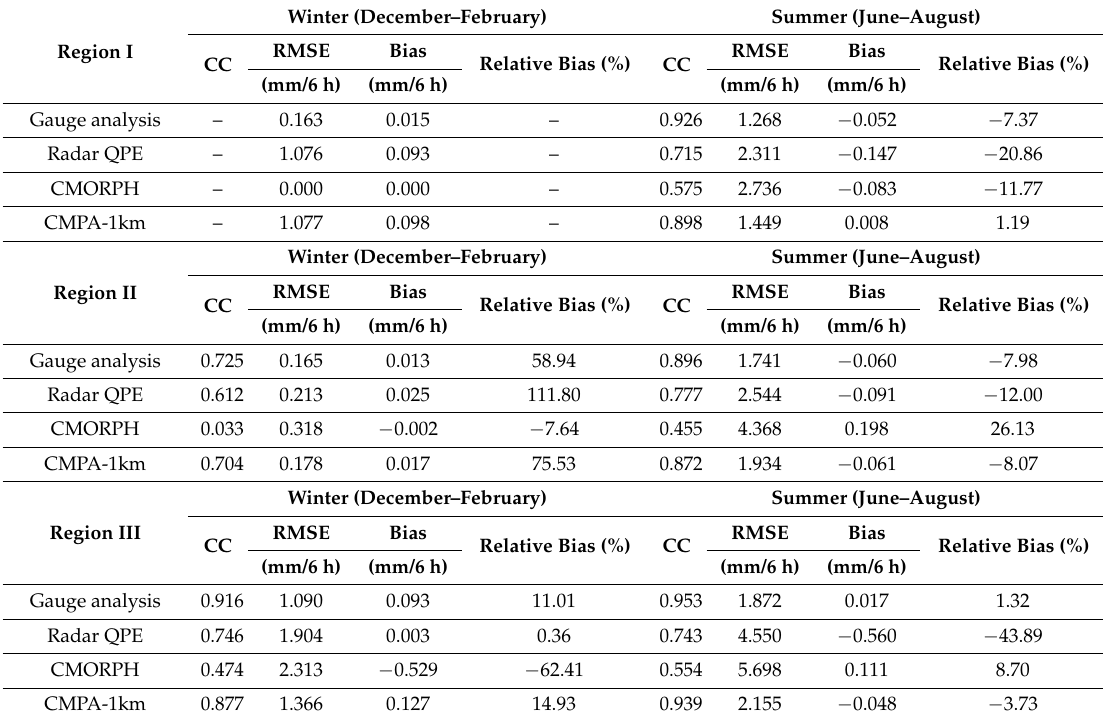
Table 7. Evaluation metrics of individual precipitation observations in summer and winter seasons over three sub-regions at a 6-h temporal resolution.